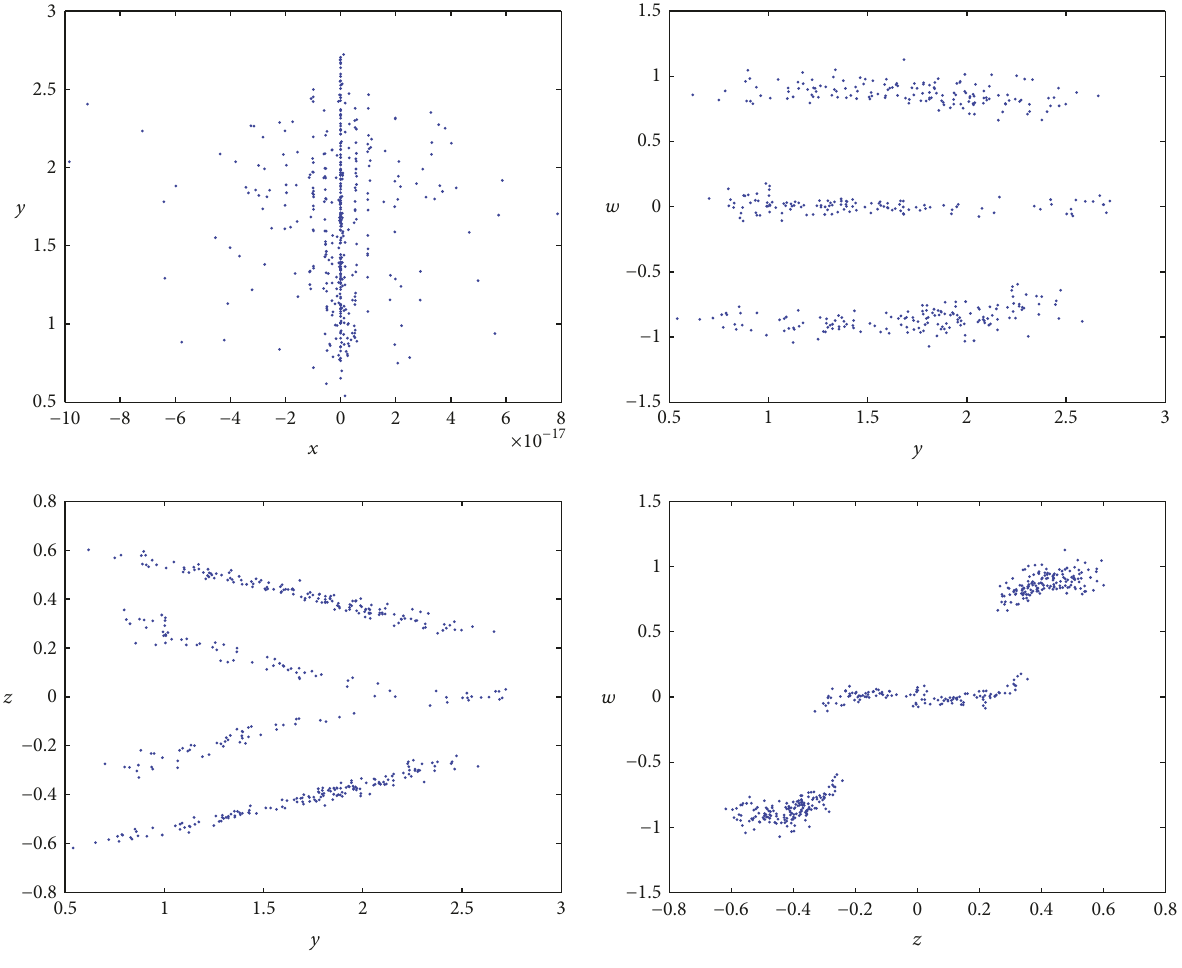
Figure 4: Poincar´e sections of system